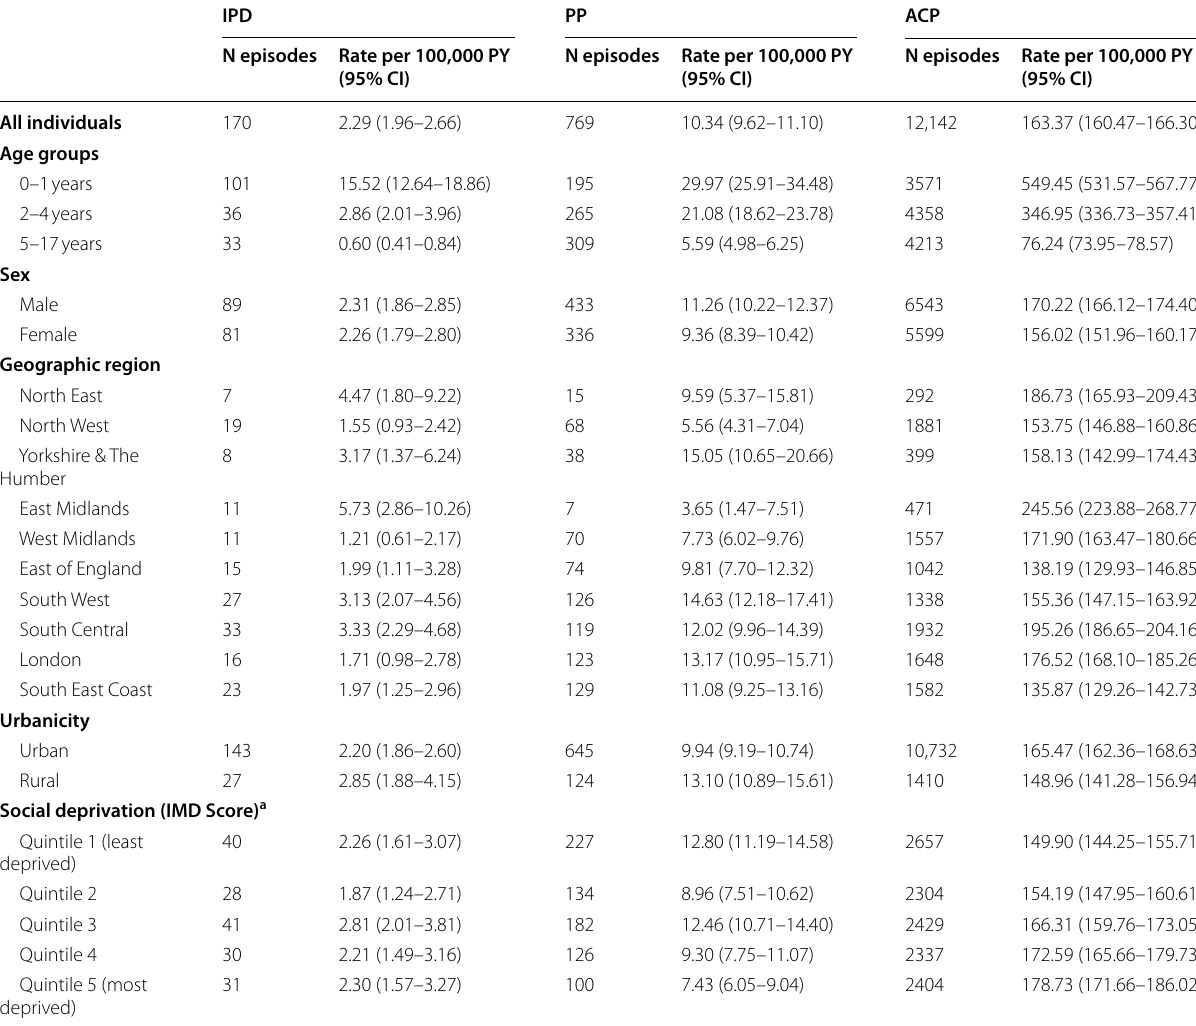
Table 2 IPD, PP and ACP IRs by patient characteristics at the time of episode